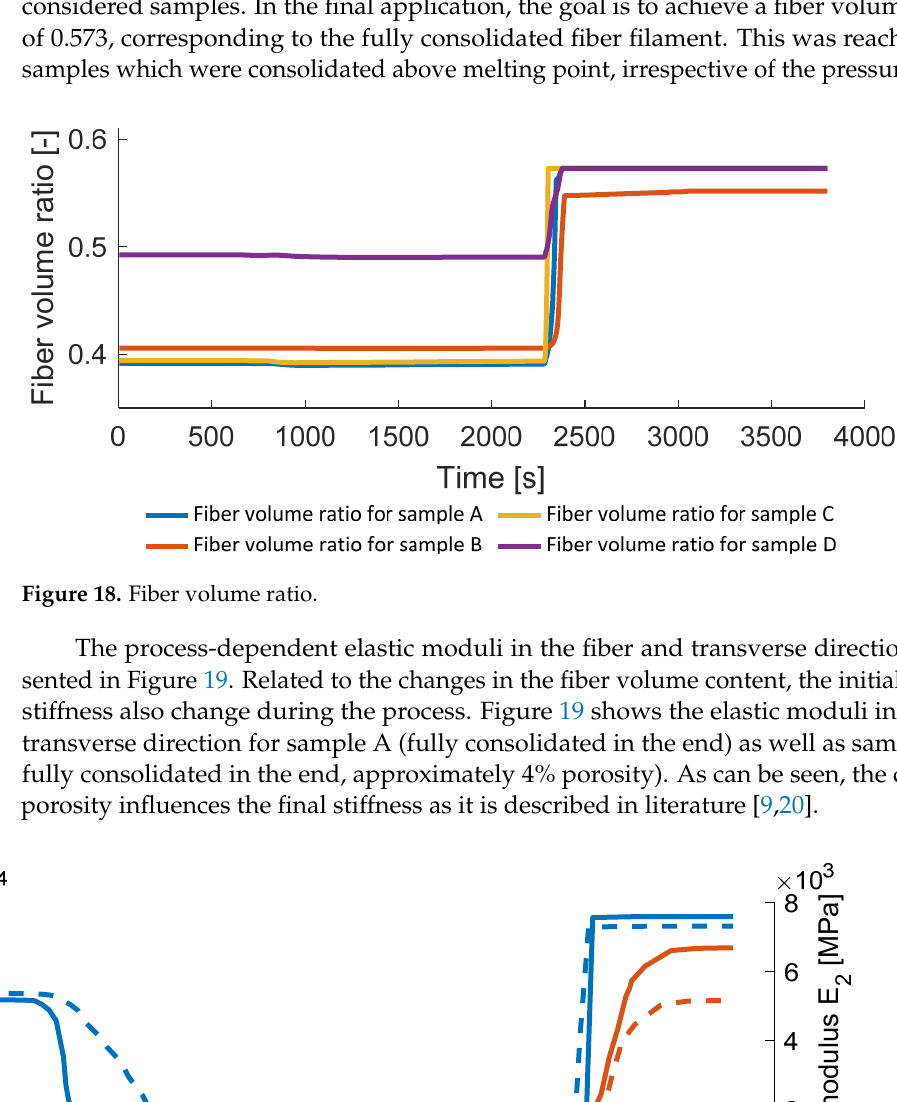
( d ) Figure 20. Final void pressure ( a ), porosity ( b ), fiber volume content ( c ), and elastic modulus in the transverse to fiber direction ( d ) in sample B (2 MPa, 175 °C). The final engineering properties are listed in Table 5 and are compared to the exper- imentally derived values from Table 1. Samples C and D have the same final engineering